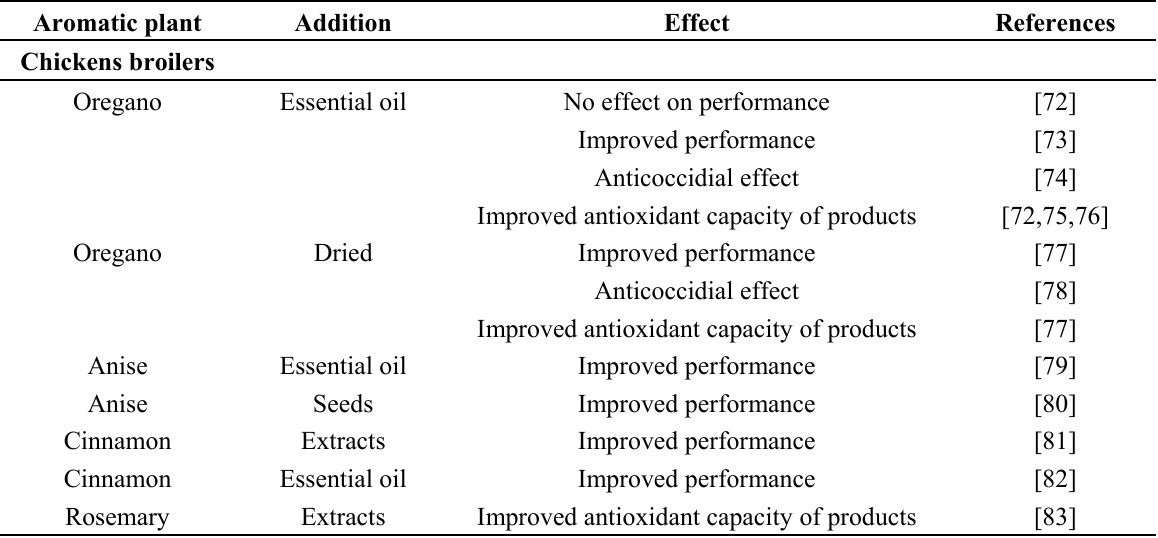
Table 1. Use of aromatic plants in animal